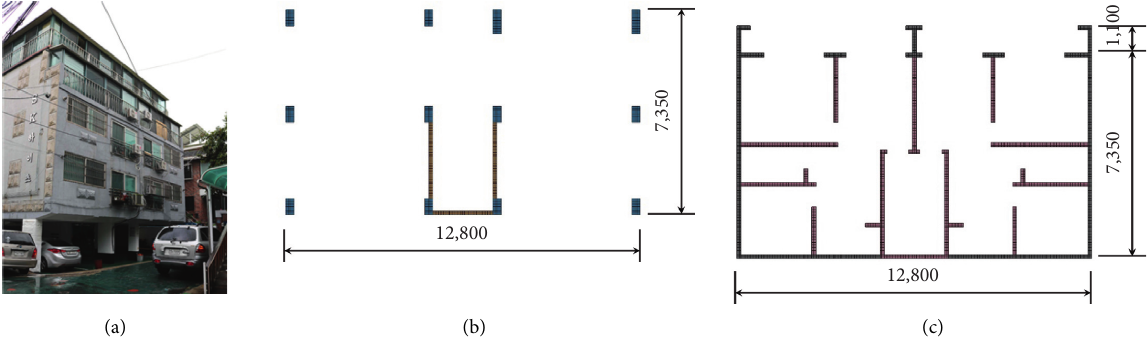
Figure 2: The objective structure of five-story piloti-type building for analysis. (a) Building appearance. (b) 1 st floor columns location and modeling. (c) 2 nd to 4 th floors wall location and modeling.